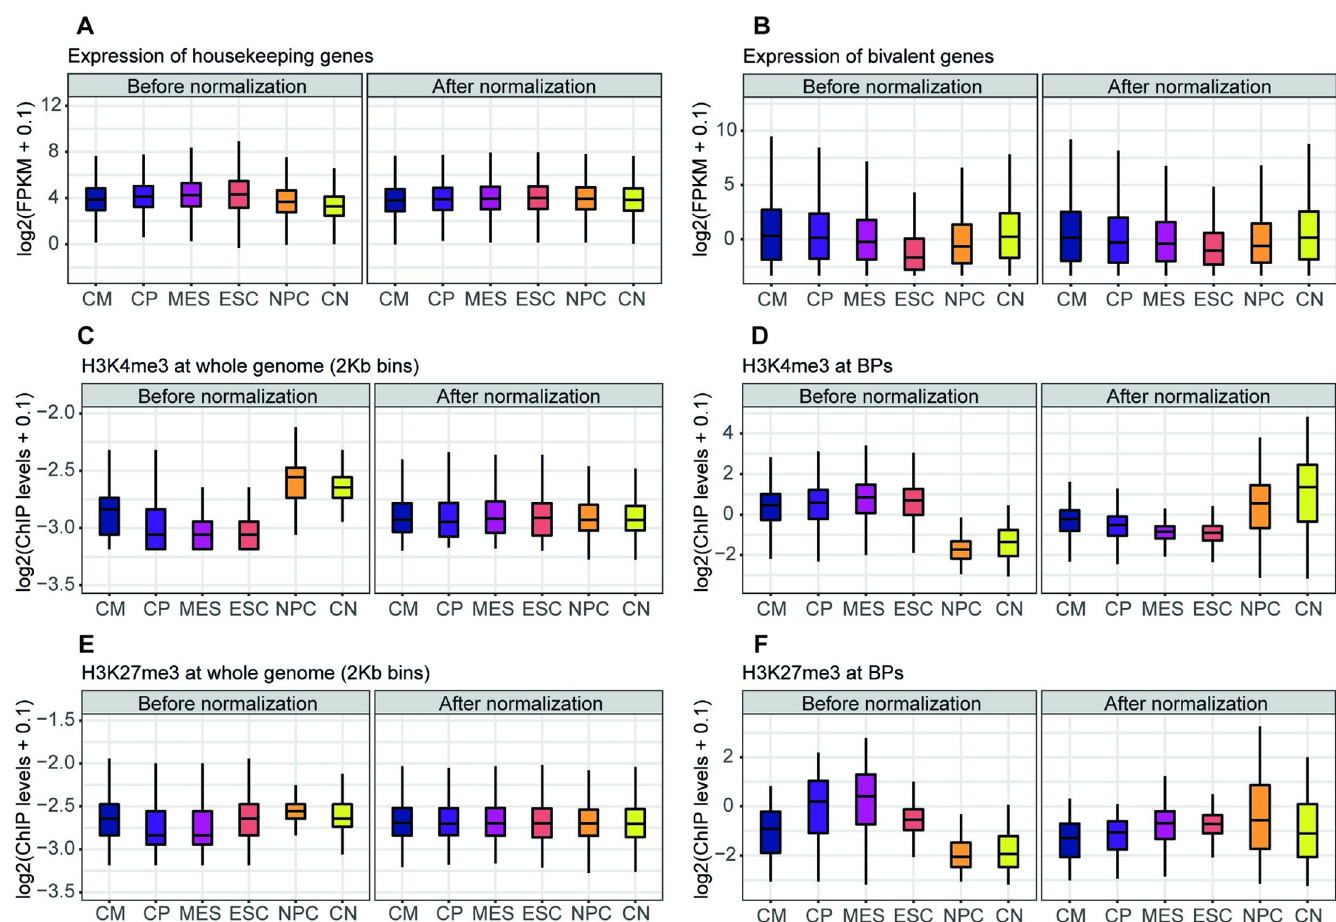
Fig 3. RNA-seq and ChIP-seq data before and after LOESS normalization. (A) Raw and normalized expression of 3,277 housekeeping genes along cardiac and neural differentiation from ESCs. (B) Raw and normalized expression of 3,459 bivalent genes along the same time points as A. (C) Raw and normalized H3K4me3 ChIP-seq signal levels at all 2-Kb bins of the genome. (D) Raw and normalized H3K4me3 ChIP-seq signal levels at 3,344 BPs. (E, F), same as C and D, respectively, but for H3K27me3. CM, cardiomyocytes; CN, cortical neurons; CP, cardio precursors; MES, mesoderm; NPC, neural precursors.